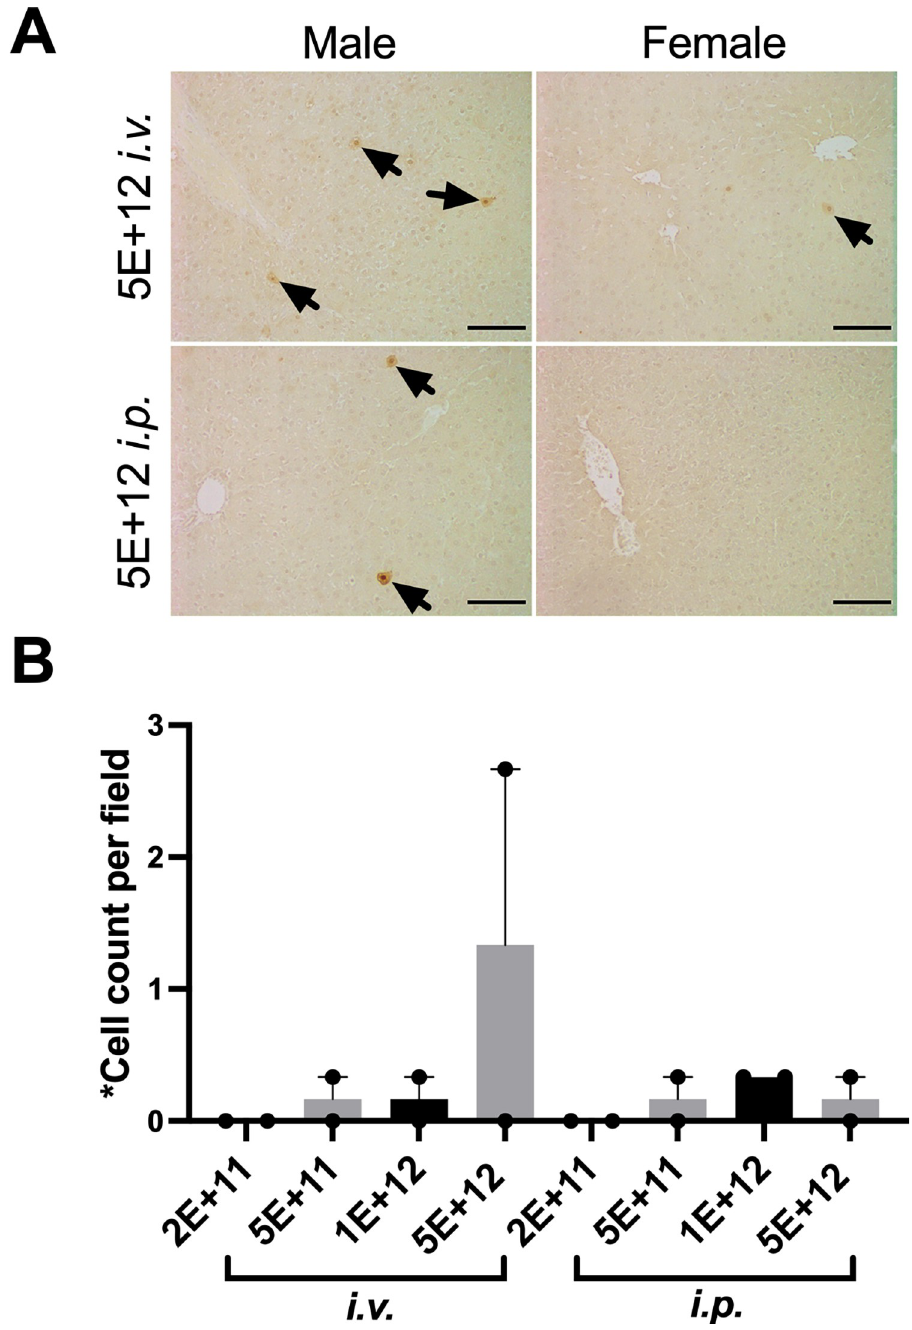
Fig 5. AAV8 has a low tropism for Lewis rat hepatocytes. (A) Representative IHC images showing EGFP expression in the livers of rat that received the highest dose (5E+12 GC) of AAV8-GFP intravenously (top) or intraperitoneally (bottom), The black arrows point to EGFP + cells. Scale bars = 100 μ m. (B) The number of EGFP positive hepatocytes per field area (13.2 mm 2 ) in male and female rat livers. N = 2 per group. Mean ± SEM.